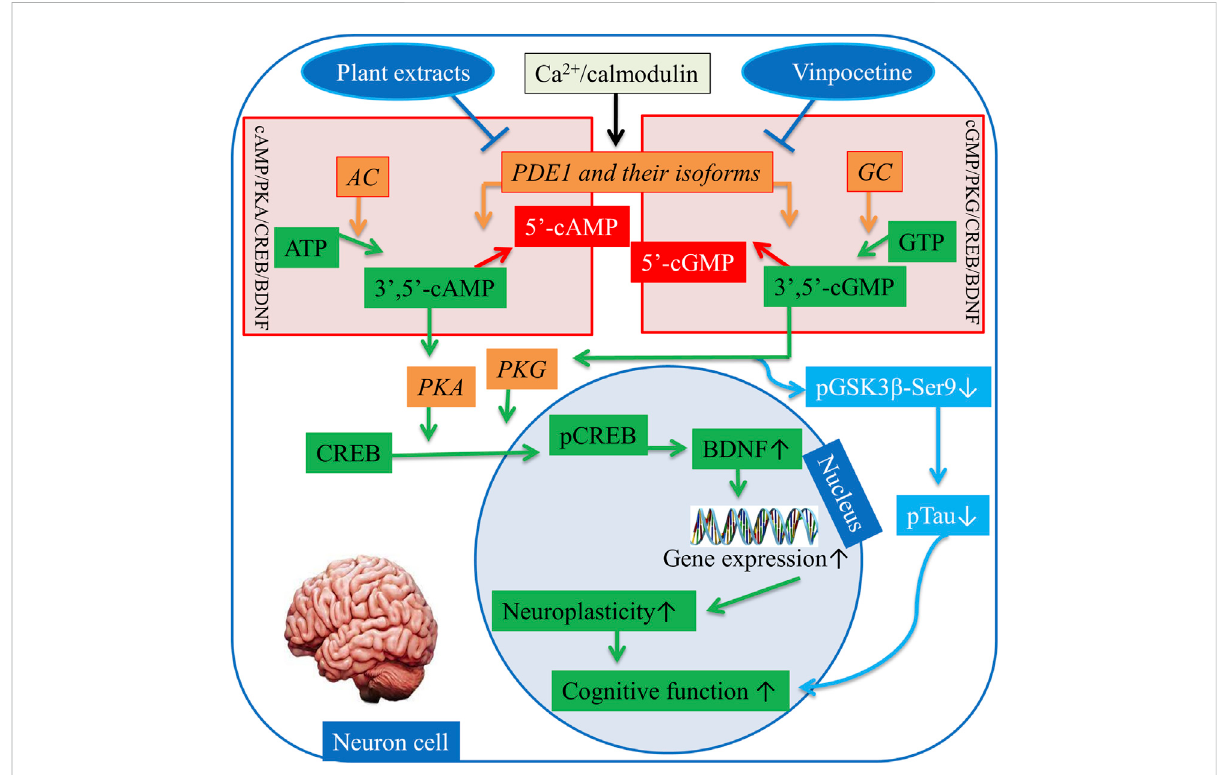
FIGURE 3 Regulation of the cAMP/PKA/CREB/BDNF and cGMP/PKG/CREB/BDNF pathways. AC = Adenylyl cyclase, GC = Guanylyl, PDE1 = Phosphodiesterase-1, ATP = Adenosine monophosphate, GTP = Adenosine guanosine monophosphate, 3 ʹ ,5 ʹ -cAMP = 3 ʹ ,5 ʹ -cyclic adenosine monophosphate, 5 ʹ -cAMP = 5 ʹ -cyclic adenosine monophosphate, PKA = Protein kinase A, pGSK3beta-Ser9 = Phosphorylated glycogen synthase kinase-3 β -(Ser9),PKG= Protein kinaseG,CREB =cAMP response element binding, pCREB =PhosphorylatedcAMP response element binding, BDNF = Brain-derived neurotrophic factor. ↑ , increase sign; ↓ , decrease